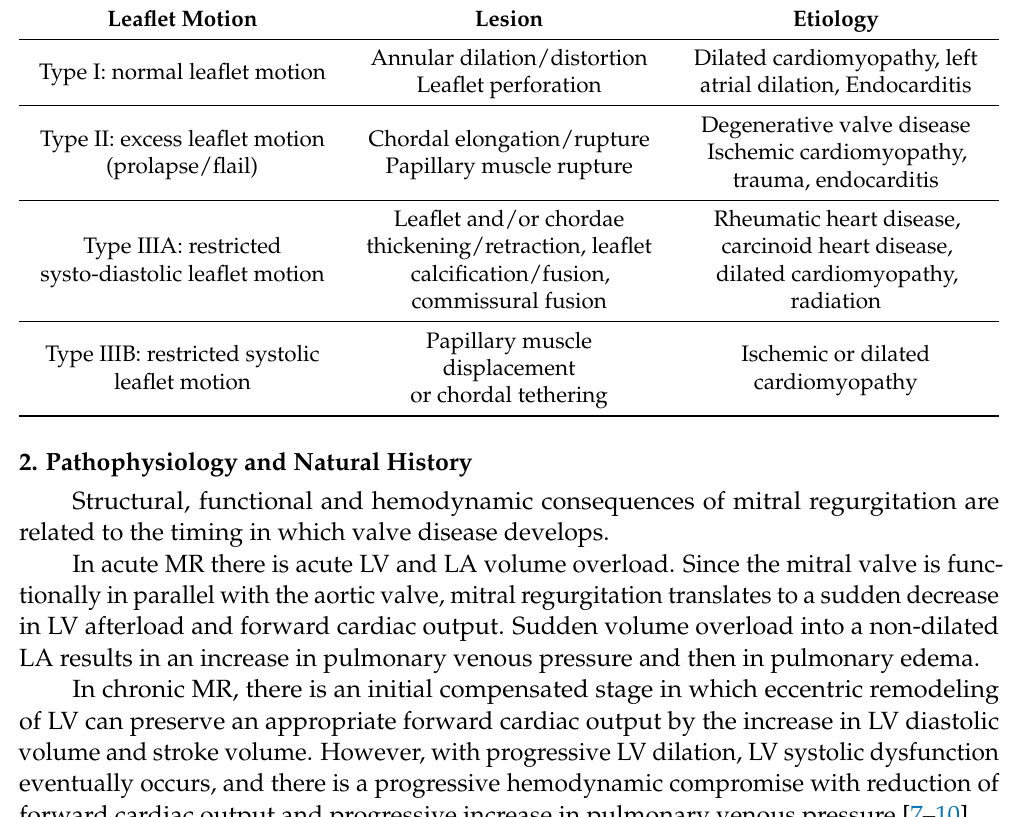
Table 1. Functional Carpentier classification [6] of mitral regurgitation and commonest underlying